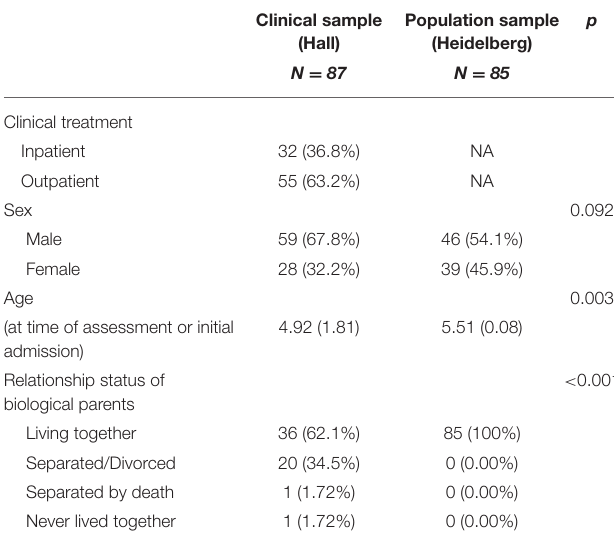
TABLE 3 | Descriptive statistics of clinically referred and general population